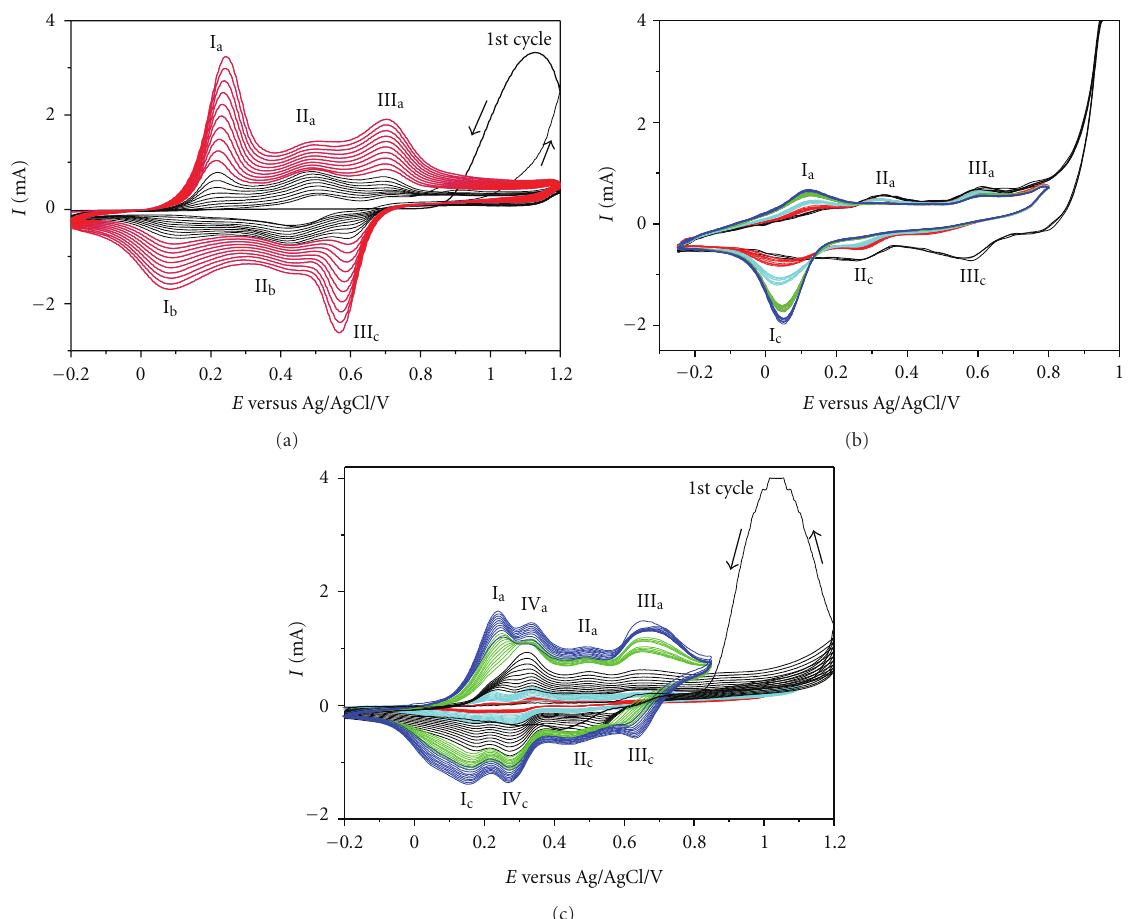
Figure 1: The cyclic voltammogramms recorded during the synthesis of (a) PANI, (b) POAP, (c) PANI-POAP films on a Pt electrode, in an aqueous solution of 0.1 M HCl and 0.4 M NaCl as electrolyte at a scan rate of 50mVs − 1 . [ANI] = 0.1 M and [OAP] = 1mM.